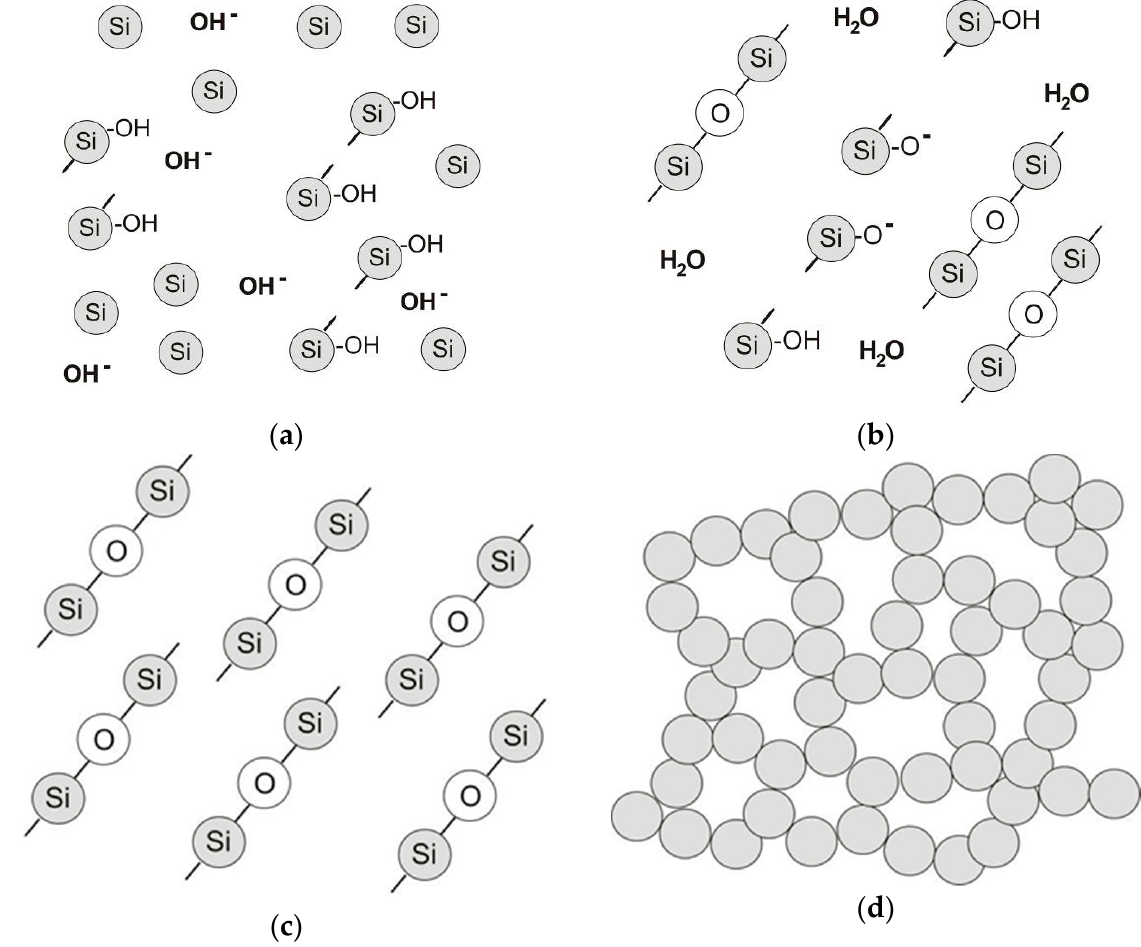
Figure 8. Binding scheme of colloidal silica-based binders: ( a ) chemical structure of the colloidal system, ( b ) reaction between hydroxyl groups from the surface of SiO 2 particles leading to the creation of siloxane bonds, ( c , d ) three-dimensional chains of SiO 2 particles. Adapted from [53].